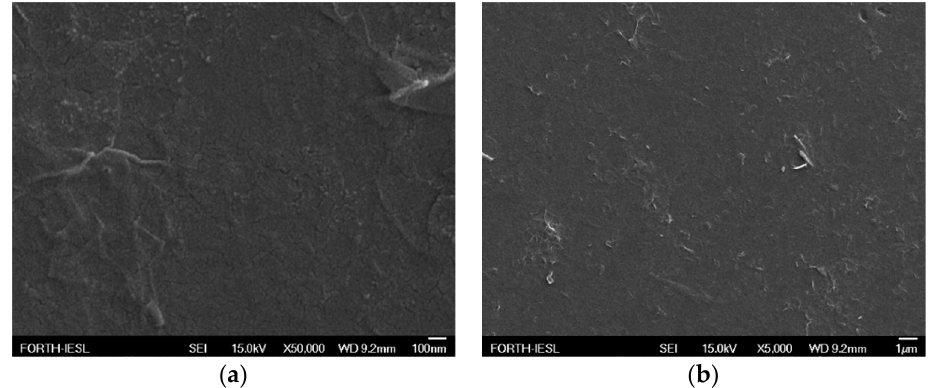
Figure 8. Top views of FE cathode surface with clearly visible edges in higher ( a ) and lower magnification scale ( b ). Distance among neighboring edges is remarkably close in the order of few microns or less.